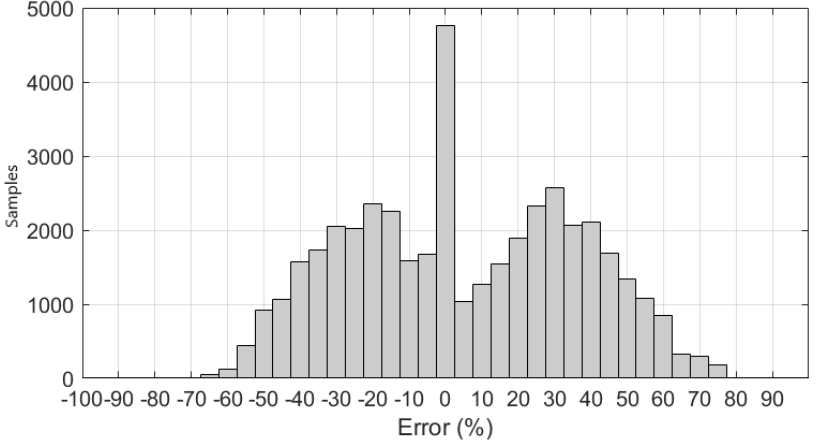
Figure 7. Difference between 100 MW, 1 h BESS power output and the AGC commands for 18 GW of wind power scenario.